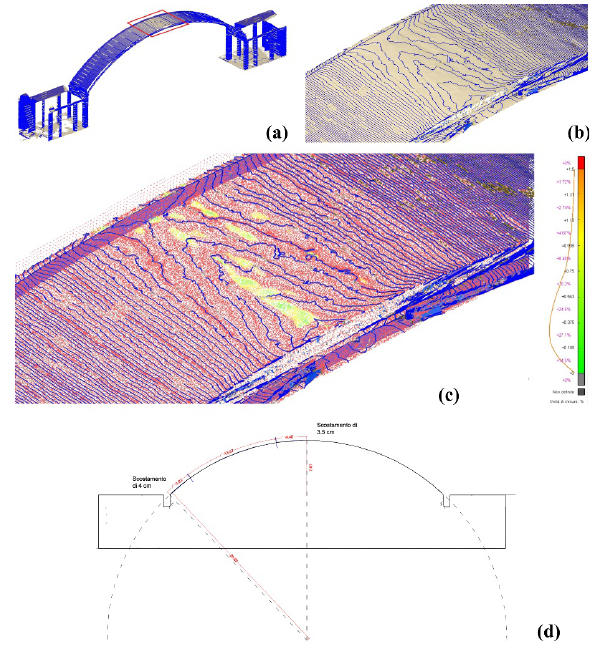
Figure 6 . Discrepancies analyses between the 3D model from Nervi’s drawings and the LiDAR point clouds after the co- Figure 7 . (a) 3D model of the arch with isocurves; (b) zoom on the registration. upper part of the arch (isocurves evidencing the anomaly); (c) slope analysis performed on the LiDAR point cloud confirming the isocurves shape anomaly; (d) Scheme representing the deviation between the vault and the generating